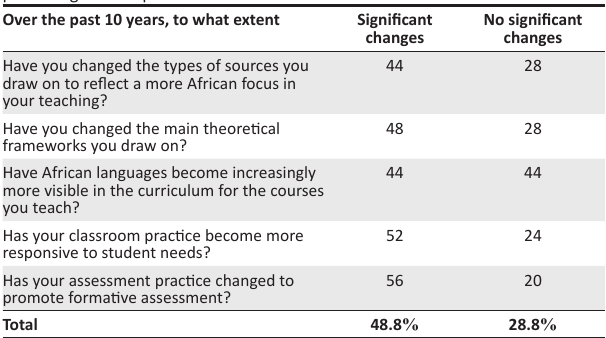
TABLE 2: Reflections on curricular change summarized and represented as percentages of responses.